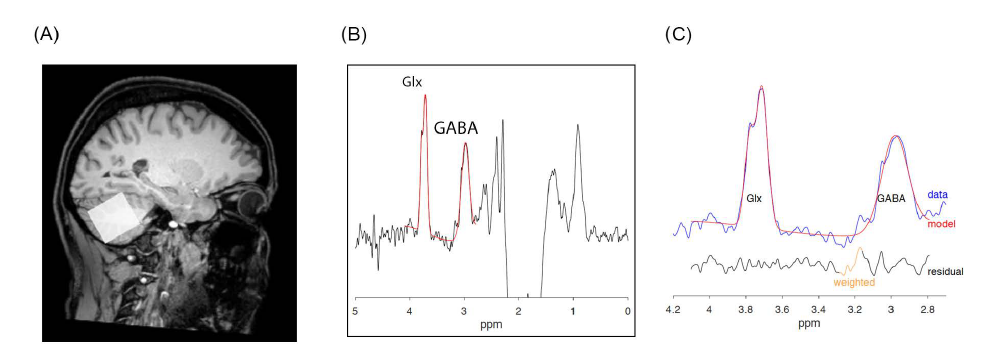
Figure 1. Cerebellar GABA and Glx spectra. Legend: ( A ) Voxel placement in the right hemi- sphere; ( B ) acquired Magnetic Resonance Spectroscopy (MRS) spectra with gamma-aminobutyric acid (GABA) and Glutamate/Glutamine complex (Glx) peaks in red, and ( C ) zoom on GABA and Glx peaks: acquired data are in blue, fit in red and residual in